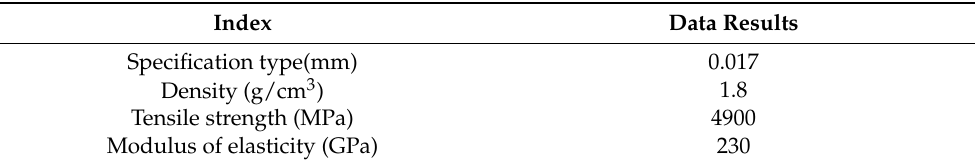
Table 1. Technical indexes of MCF.